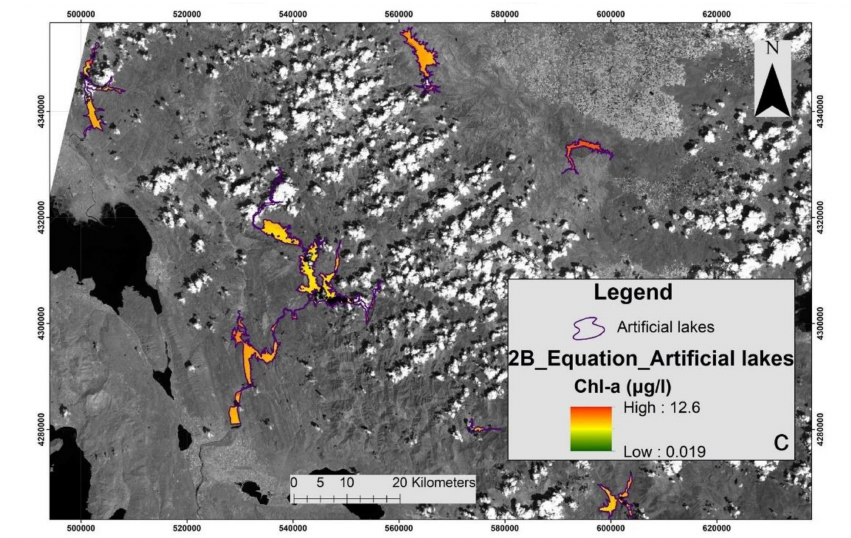
Figure 6. Satellite-derived Chl- a maps (on 11 August 2013) of selected lakes after the application of 1A ( a), 2A ( b ), and 2B ( c ) models (WGS_1984, UTM Zone 34 N Coordinate